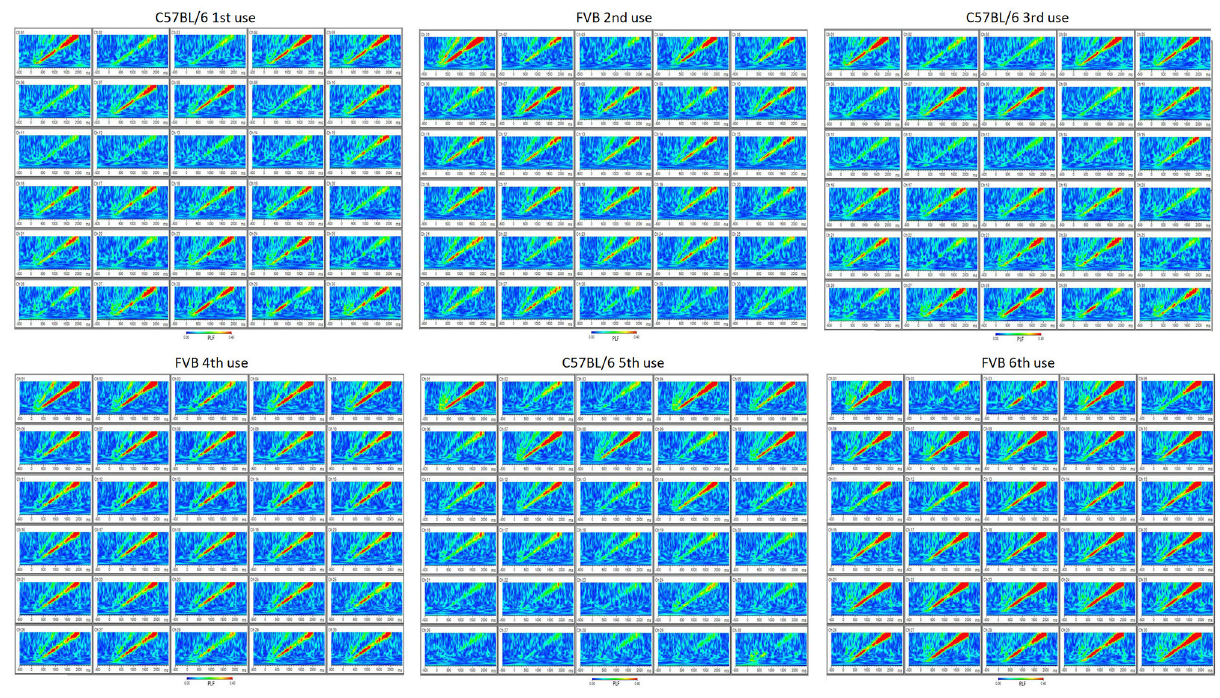
Frontiers in Integrative Neuroscience |